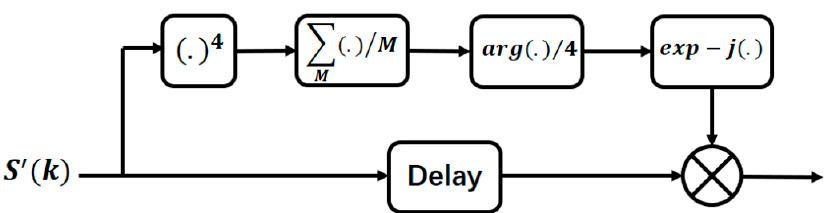
Figure 4. Block diagram of carrier phase estimator.